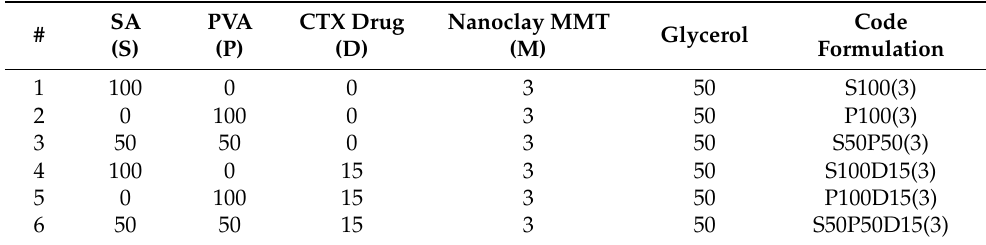
Table 1. CTX-loaded (or unloaded) SA/PVA nanocomposites reinforced with MMT nanoclay ( n = 6). All the values are expressed in